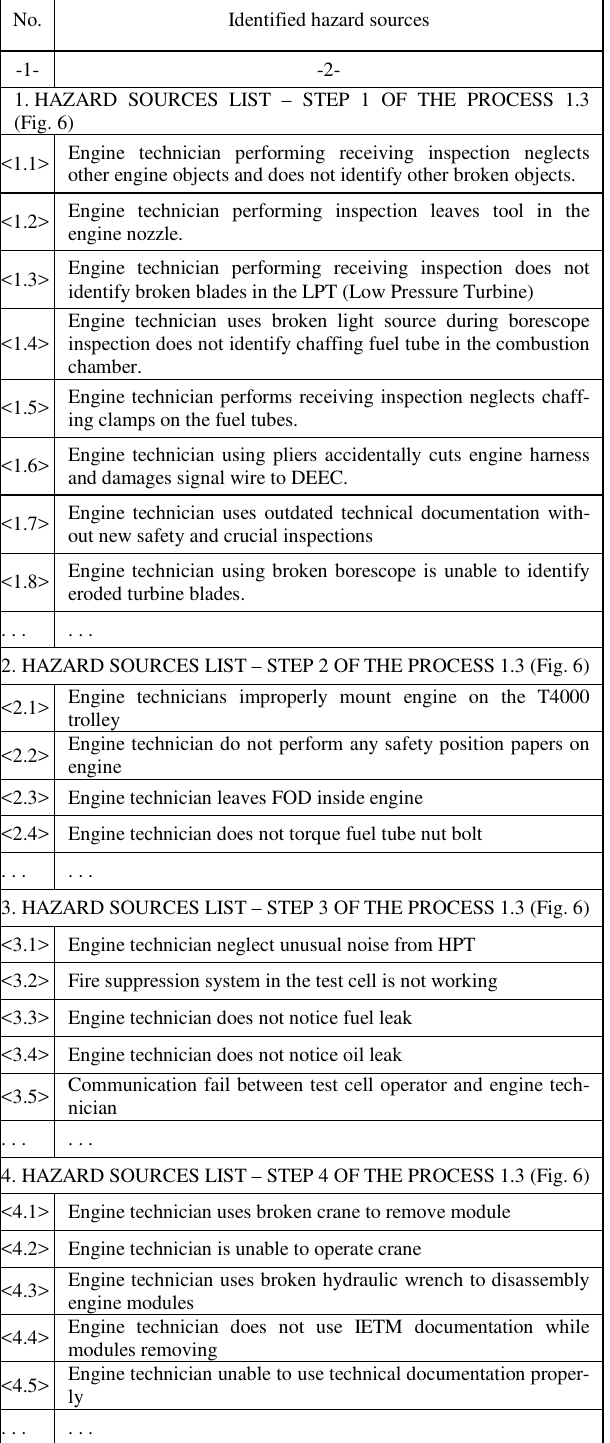
Table 1. List of the selected identified hazard sources in the analysis domain (Engine Intermediate level maintenance) within process 1.3 (major engine objects discrepancies removal) – Fig. 3 and